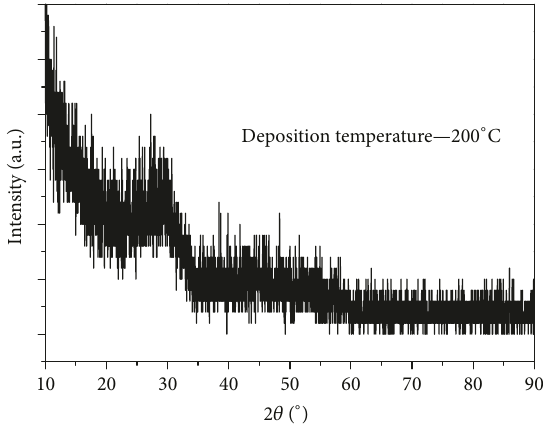
Figure 1: XRD spectra of sample deposited at 200 ∘